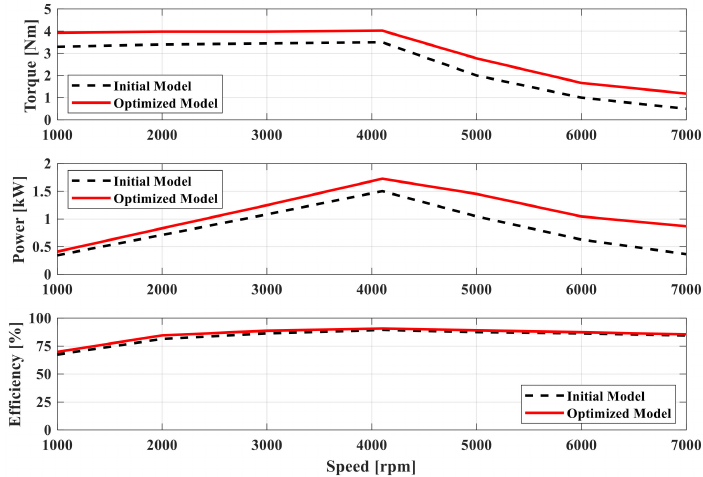
Figure 13. Characteristics of proposed